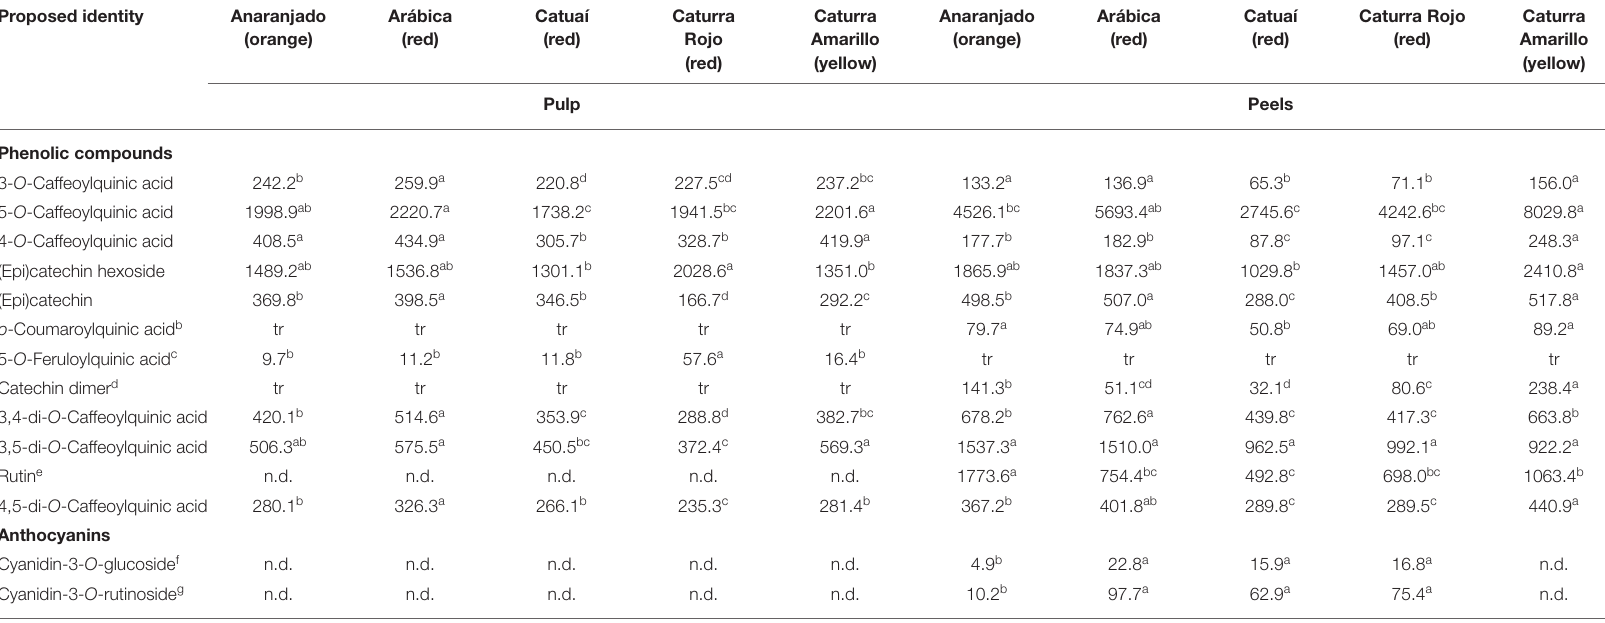
TABLE 2 | Concentration (mg/kg DM) of major phenolic compounds in pulp and peels of different coffee varieties a . Proposed